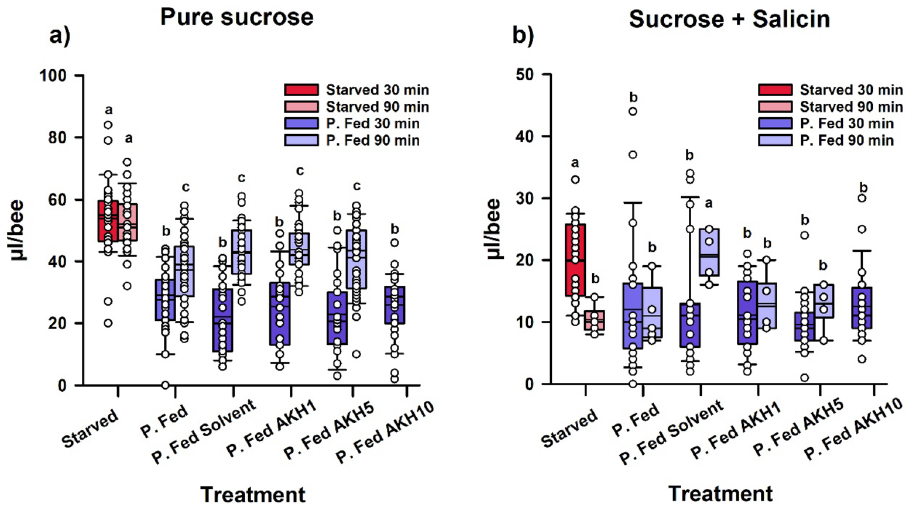
Figure 4. Ingestion (µl/bee) of partially fed foraging bees (‘P. Fed’) treated or not with AKH, when presented with a pure 0.6 M sucrose solution ( a ) or a 0.6 M sucrose solution spiked with 100 mM salicin ( b ). Food was provided 30 min or 90 min after the topical treatment. Bees were either starved (‘Starved’) or partially fed with a honeydew diet. Partially fed bees were left untreated (‘P. Fed’), topically exposed with solvent (‘P. Fed solvent’) or with AKH (either 1, 5 or 10 µg; ‘P. Fed AKH1’, ‘P. Fed AKH5’, or ‘P. FedAKH10’ respectively). ( a ) Consumption of pure 0.6 M sucrose solution. Thirty min after topical treatment, starved bees (red box; n = 29) consumed significantly more 0.6 M sucrose solution than partially fed bees (blue boxes). P. Fed (n = 27), P. Fed solvent (n = 27), P. Fed AKH1 (n = 22), P. Fed AKH5 (n = 24) and P. Fed AKH10 bees (n = 30) did not differ in their consumption of sucrose solution. Ninety min after topical treatment, food consumption increased in P. Fed bees (light-blue boxes), which had used probably part of their reserves, but the general response pattern remained the same: starved bees (pink box; n = 26) consumed significantly more 0.6 M sucrose solution than P. Fed bees. No significant differences were found between P. Fed (n = 32), P. Fed solvent (n = 37), P. Fed AKH1 (n = 34) and P. Fed AKH5 bees (n = 36). ( b ) Consumption of pure 0.6 M sucrose solution containing 100 mM salicin. Thirty min after topical treatment, starved bees (red box; n = 24) consumed significantly more 0.6 M sucrose solution spiked with salicin than P. Fed bees (blue boxes). P. Fed (n = 26), P. Fed solvent (n = 26), P. Fed AKH1 (n = 20), P. Fed AKH5 (n = 21) and P. Fed AKH10 bees (n = 24) did not differ in their consumption of sucrose solution spiked with salicin. Salicin reduced significantly the consumption of sucrose solution compared to pure sucrose solution (note the different ordinate scale in ( a,b ), which was changed to appreciate data dispersion) but no effect of AKH was detected. Ninety min after topical treatment, food consumption decreased in starved bees (pink box; n = 6), which did not differ from all P. Fed groups except for the P. Fed solvent group (n = 5 for P. Fed; n = 6 for P. Fed solvent, P. Fed AKH1 and P. Fed AKH5). In both panels, data shown are the median (horizontal line) and the 10th, 25th, 75th and 90th percentiles as vertical boxes with error bars and the corresponding overlaid scatter plots. Different letters above boxes indicate significant differences (P <